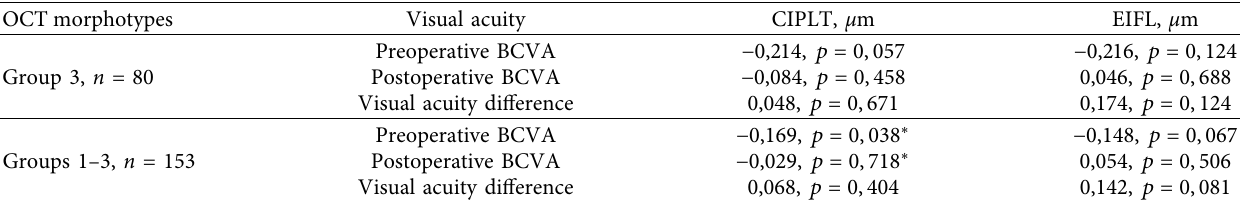
Table 5: Pearson’s correlations ( R 2 ) between CIPLT and EIFL in OCT morphotypes of ERM, pre- and postoperative BCVA, and post- operative visual acuity difference with designation of the corresponding significance level ( p -value). ∗ p < 0 ,